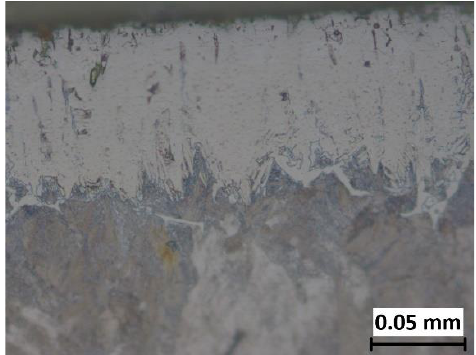
Figure 3. Optical micrograph of a layer boronized at 920 °C for 4 h, magnification 500:1.